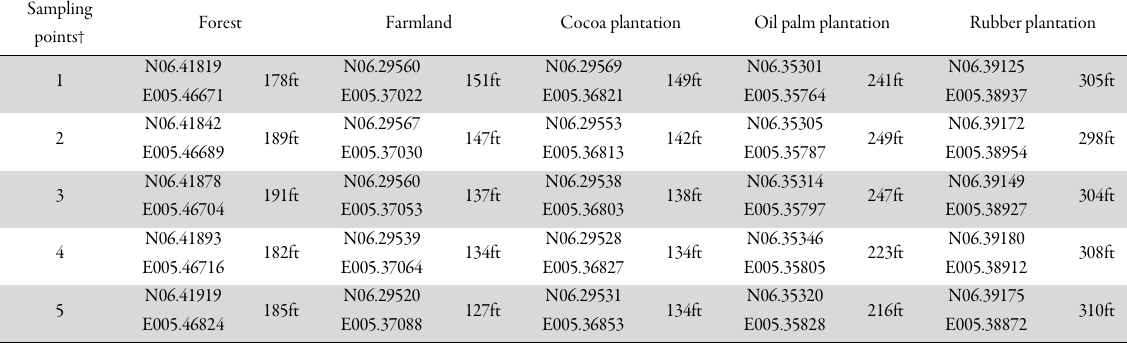
Table 1. Geo-position of soil sampling points within five land use types in Okomu Forest Reserve, Edo State, Nigeria Sampling